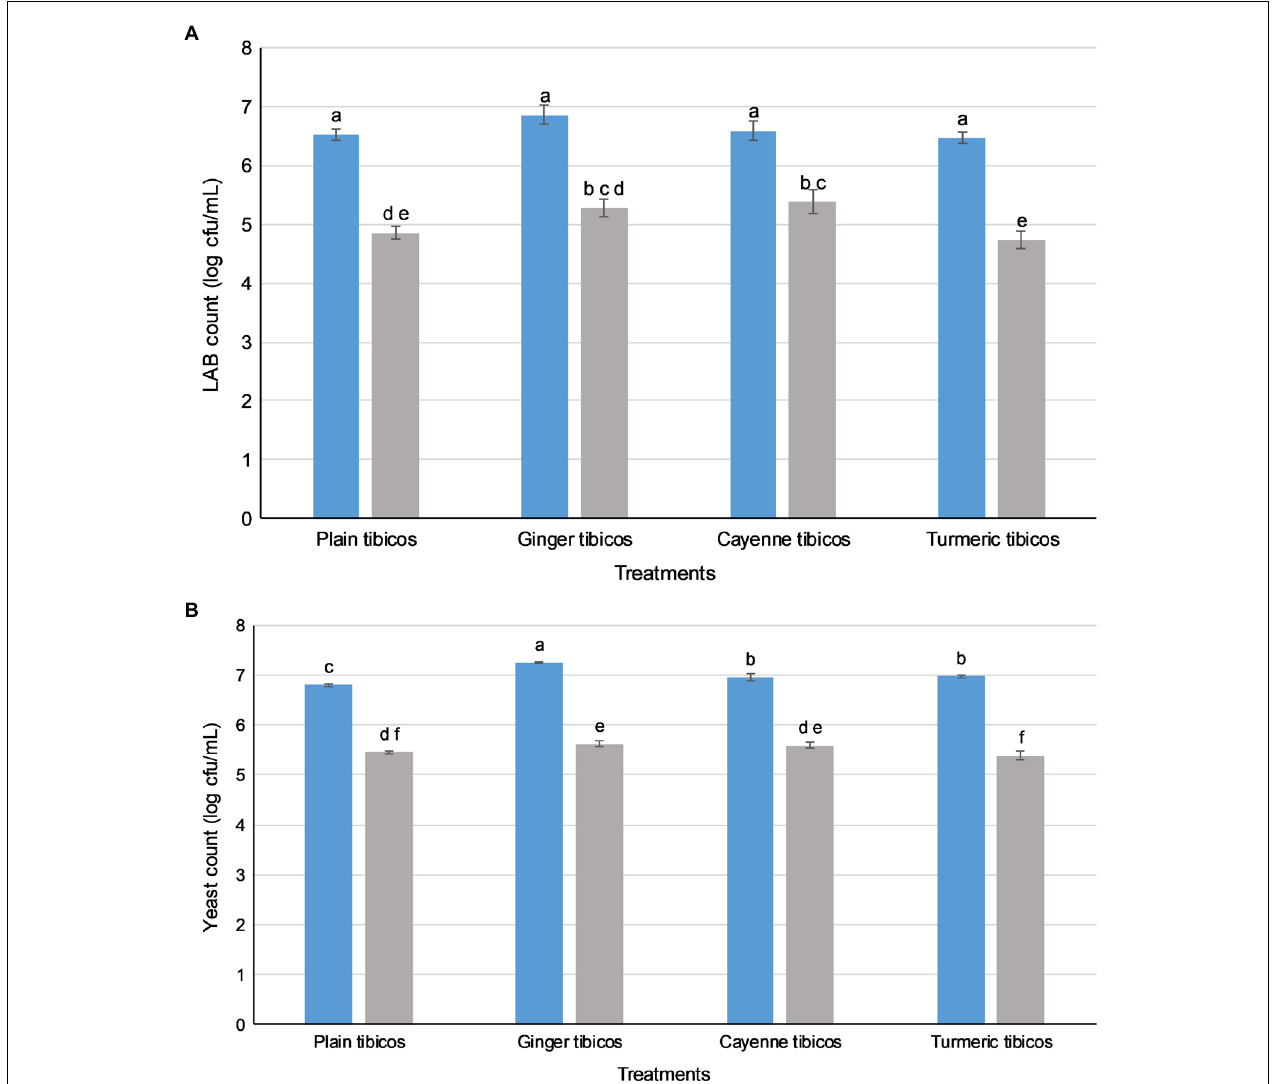
FIGURE 4 | Lactic acid bacteria (LAB) and yeasts in tibicos survive simulated oral, gastric, and small intestinal conditions. LAB (A) and yeast (B) counts. ( ) LAB or yeast counts before in vitro digestion; ( ) LAB or yeast counts after simulated GI conditions. The results were expressed as mean standard deviation ( n = 3) for each treatment group. Means with the same letter are not significantly different ( p <